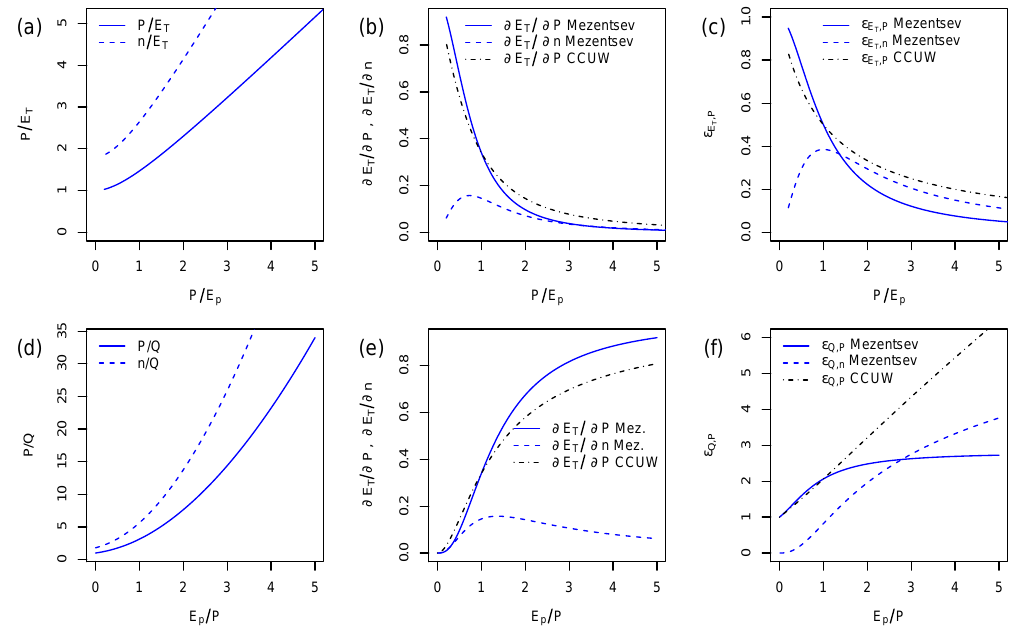
Fig. 7. Sensitivity coefficients and their components as functions of the humidity and aridity index, respectively. Baseline water balance terms ( E T and Q =1 − P ) have been determined with the Mezentsev function and n =1.8. For illustration purposes we set P =1 and E p =0 ... 5. Top panels display components of the sensitivity of actual evapotranspiration E T to precipitation P and the catchment parameter n as functions of the humidity index P/E p using terms of Eq. (21). The bottom panels display components of the sensitivity coefficient of streamflow Q to P and n as functions of the aridity index E p /P using terms of Eq. (22). The left panels depict the left term of the sensitivity coefficients, the middle panels the right term (solutions of the partial differentials ∂E T and ∂E T ) and the right panels show the sensitivity ∂n ∂P